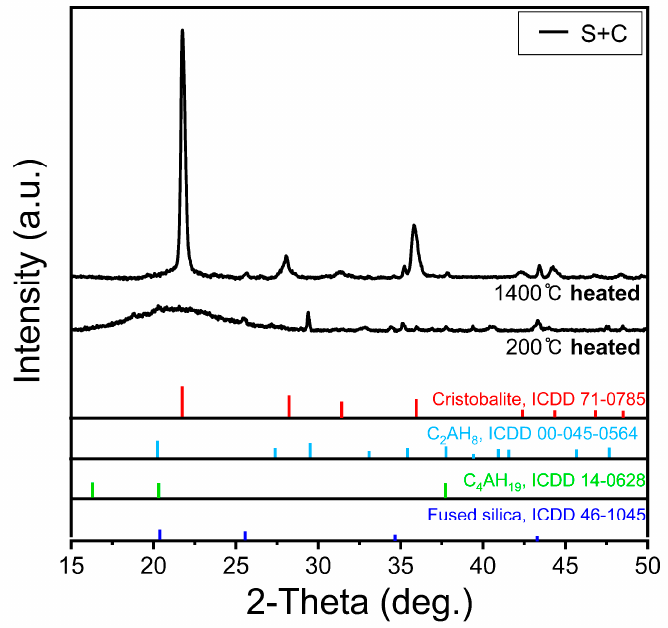
Figure 6. XRD peaks after heat treatment at 200 °C and 1400 °C of silica sand and CAC mixed molded body.